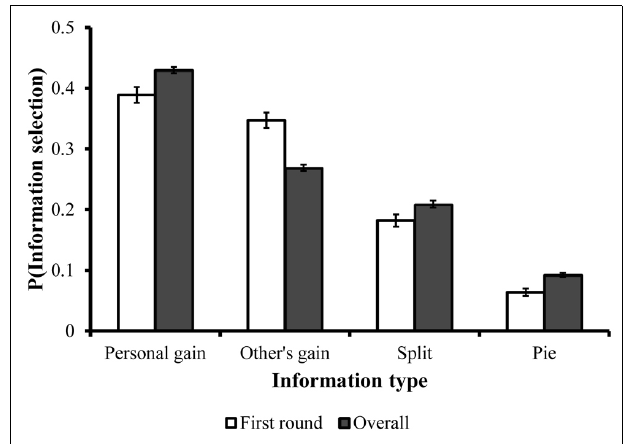
FIGURE 2 | Overall information search pattern and search pattern in the first phase in Experiment 2. Error bars are depicted in black lines.